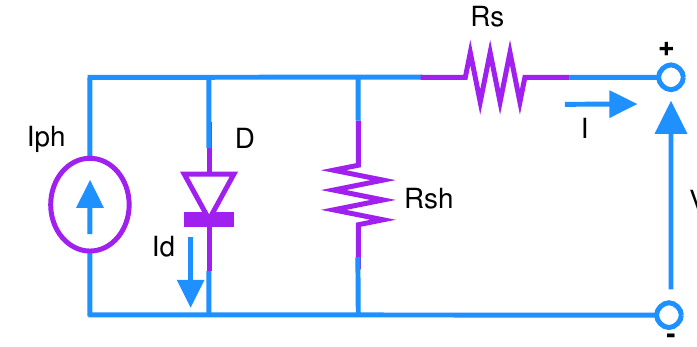
Figure 3. Single-diode equivalent circuit of Solar-PV